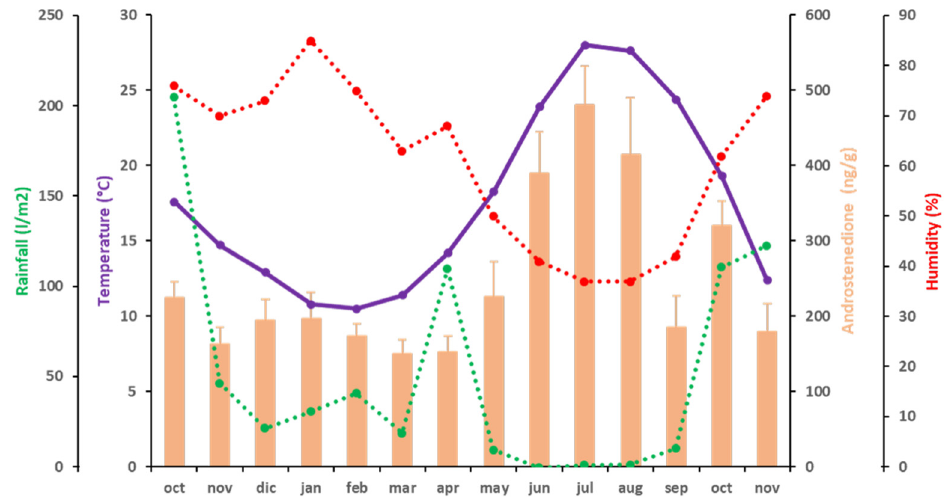
Figure 2. Correlations between A4 (orange bars) and climatic variables [temperature (purple), rainfall (green) and humidity (red)] during the period of study. A discontinuous line represents independence of the variable.